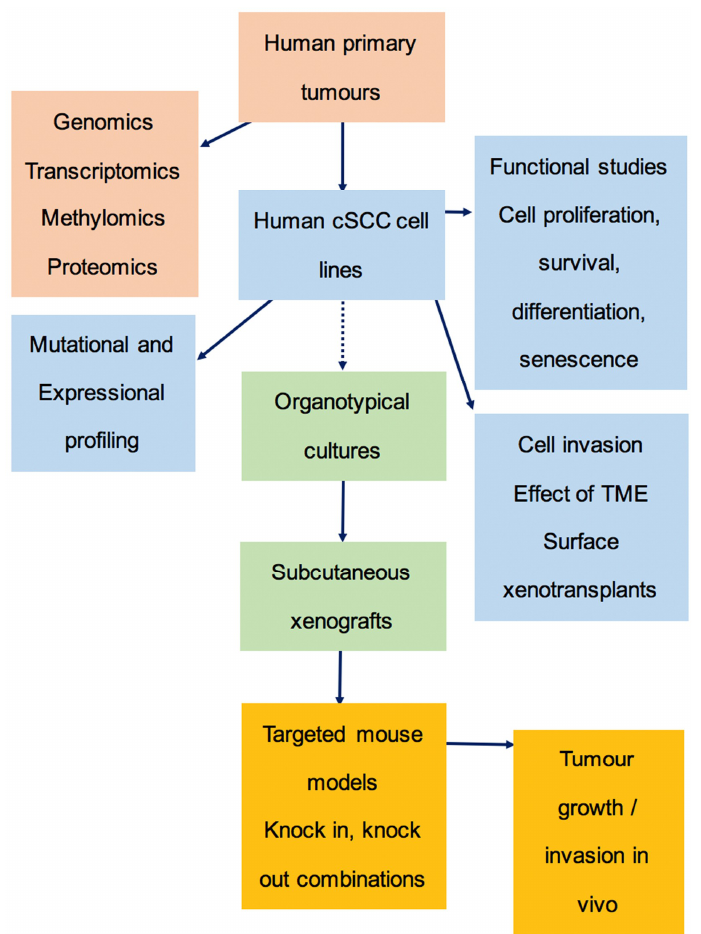
Figure 6. Preclinical pipeline. A pipeline diagram demonstrating the process of cSCC cell line establishment and characterisation, and potential preclinical investigations. TME; tumour microenvironment.